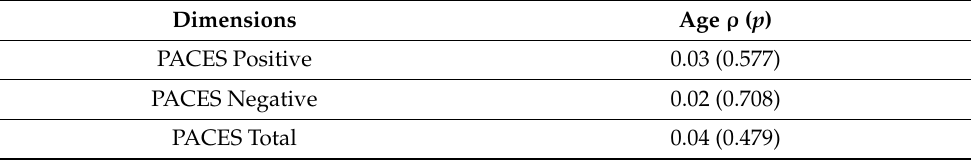
Table 5. Correlations between the age variable and PACES